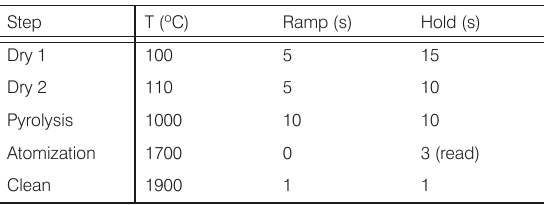
Sb hollow cathode lamp; lamp current: 10 mA; wavelength: 217.6 nm; slit: 0.2 nm; peak area measurements; integration time: 3